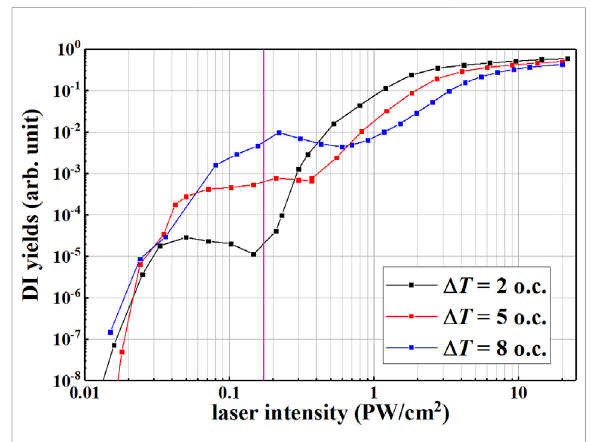
FIGURE 2 Variation curve of double ionization yield with linearly polarized laser intensity for three different delay times under compound laser fi eld. The vertical pink lines indicate the non- sequentialdoubleionization ofAratomsinacompoundlaser fi eld with a fi eld strength of 0.16 PW/cm 2 .